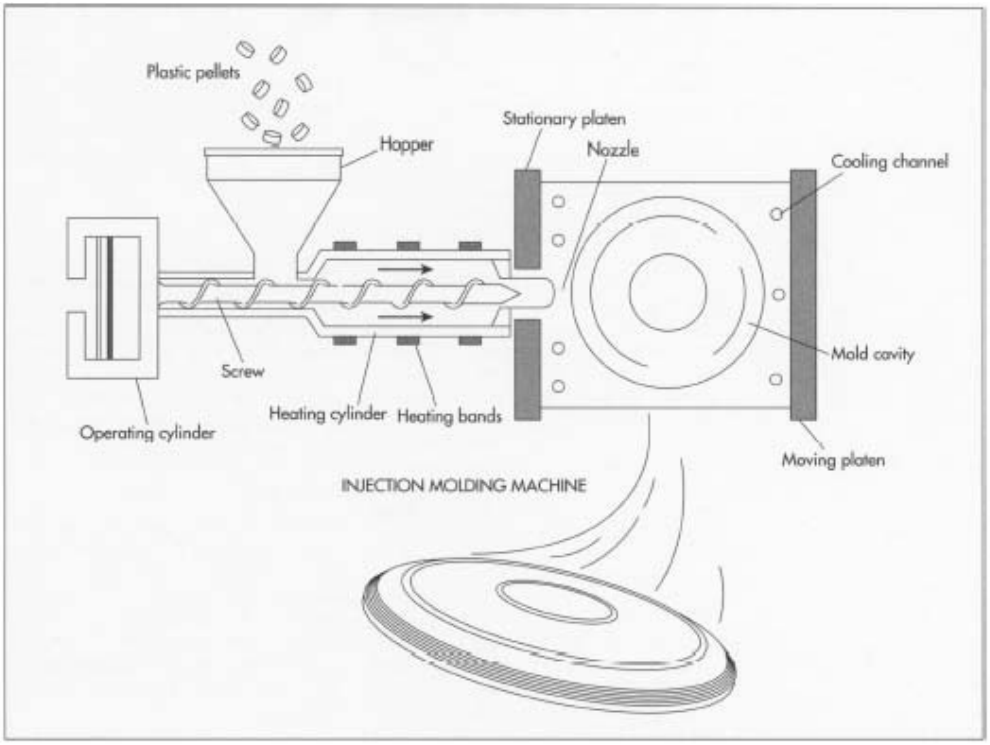
Fig. 1. Injection